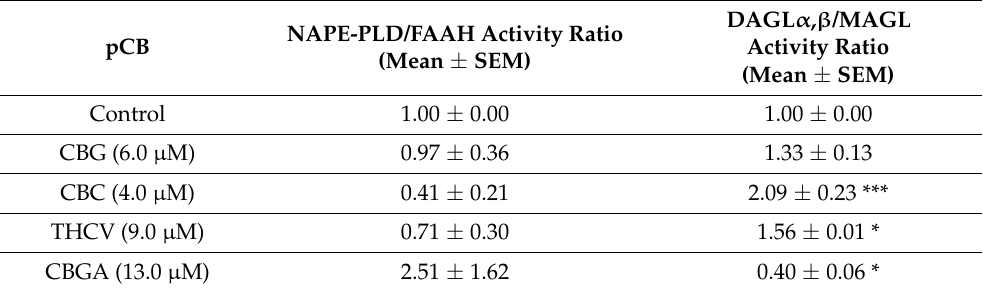
Table 4. Activity ratios of NAPE-PLD/FAAH and DAGL α , β /MAGL with respect to the control (control was set to 1.00). Data are from Figure 7 (* p < 0.05 and *** p < 0.001 vs. control).